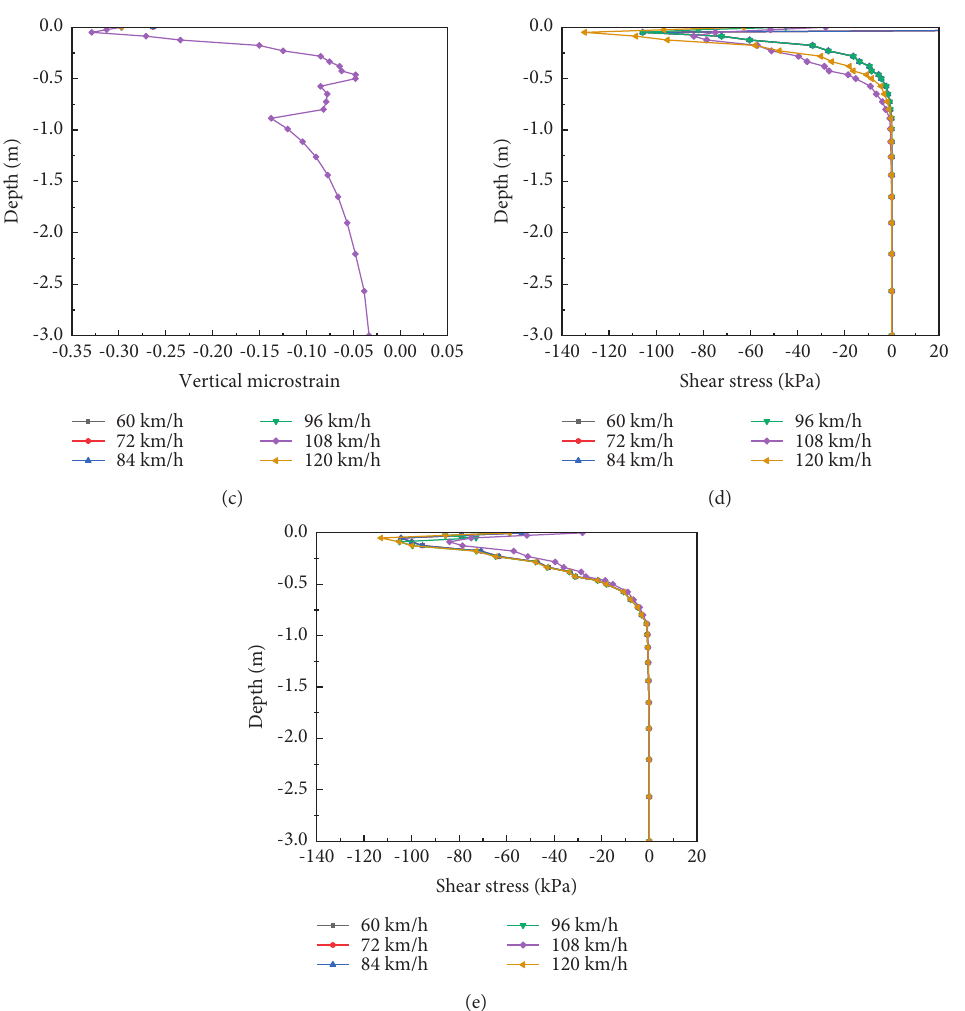
Figure 12: (a) Variation of vertical displacement with depth at different speeds. (b) Variation of vertical stress with depth at different speeds. (c) Variation of vertical micro strain with depth at different speeds. (d) Variation of longitudinal shear stress with depth at different speeds. (e) Variation of transverse shear stress with depth at different